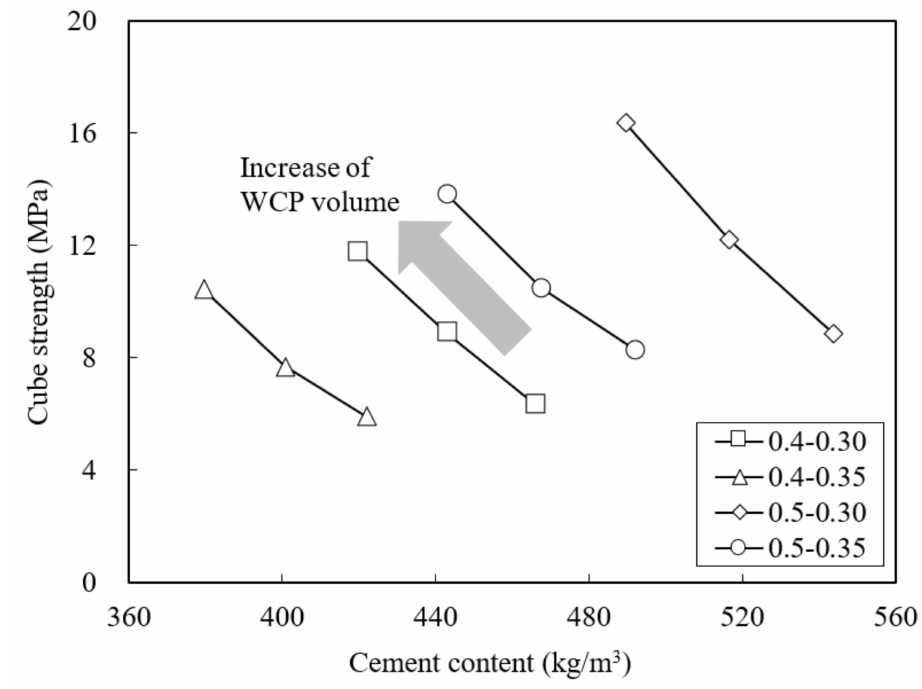
Figure 15. Cube strength versus cement